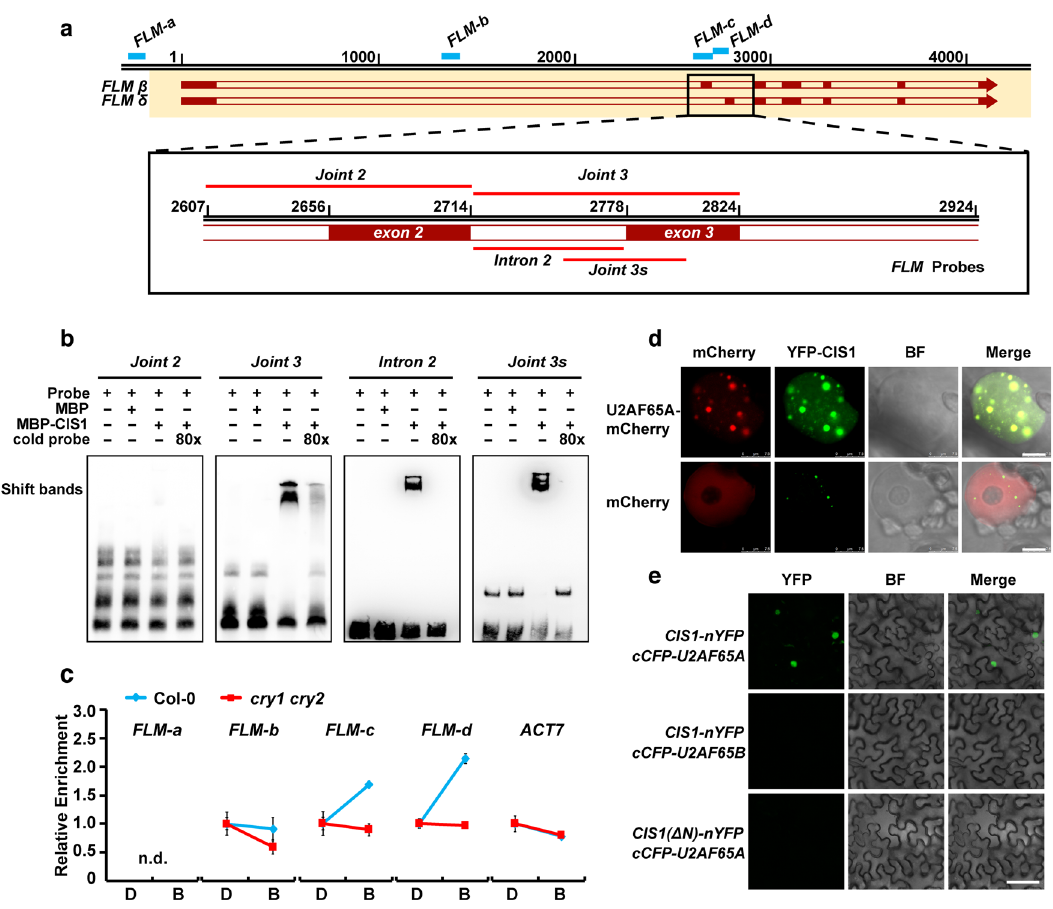
Fig. 6 | CRYs regulates the RNA-binding activity of CIS1 to modulate FLM splicing. a Diagram illustrating the locations of RNA probes (red lines) and primer pairs(bluebars)usedinRNA-EMSAandRIPassays. b RNA-EMSAassayshowingthat CIS1bindsto the FLM Joint3probebut not FLM Joint 2in vitroand that CIS1shows the strongest binding af fi nity to short FLM Joint 3 ( FLM Joint 3s) among the short probes (Intron 2 and FLM Joint 3s). RNA probes are indicated in ( a ). c RIP-qPCR assay showing the binding af fi nity of CIS1 protein to FLM pre-mRNA in vivo. Col-0, cry1cry2 ,and cis1-1 (mock)seedlingsweregrownat22°CinLDconditionfor7days and pretreated with darkness (D) for 24h, treated with MG132 for 2h, and trans- ferred to blue light (B, 30 μ molm − 2 s − 1 ) for 4h. RNA fragments (200 – 400 nt) extracted from seedlings were immunoprecipitated with anti-CIS1 agarose beads